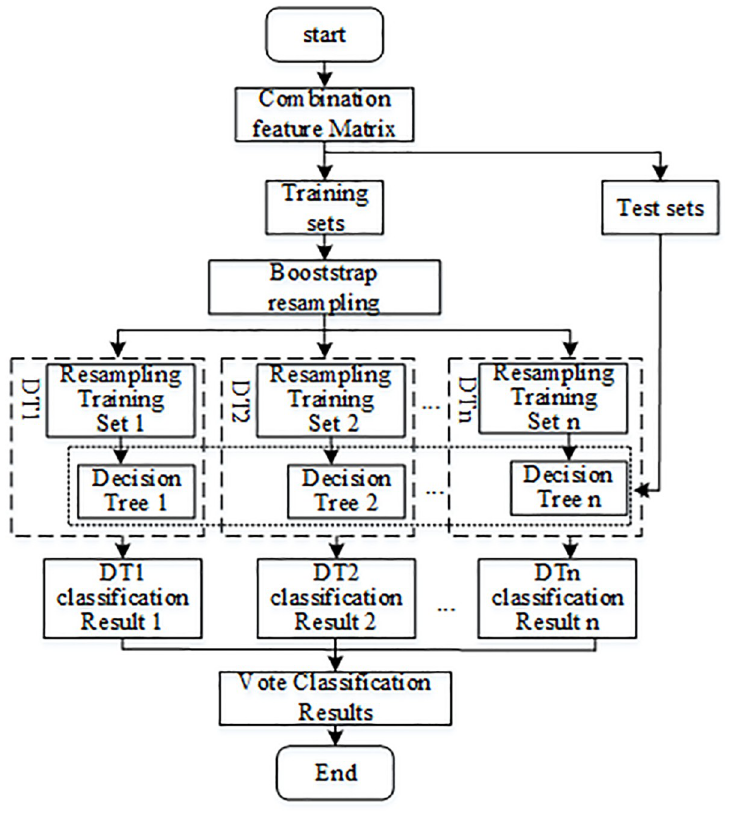
Fig 8. Random forests